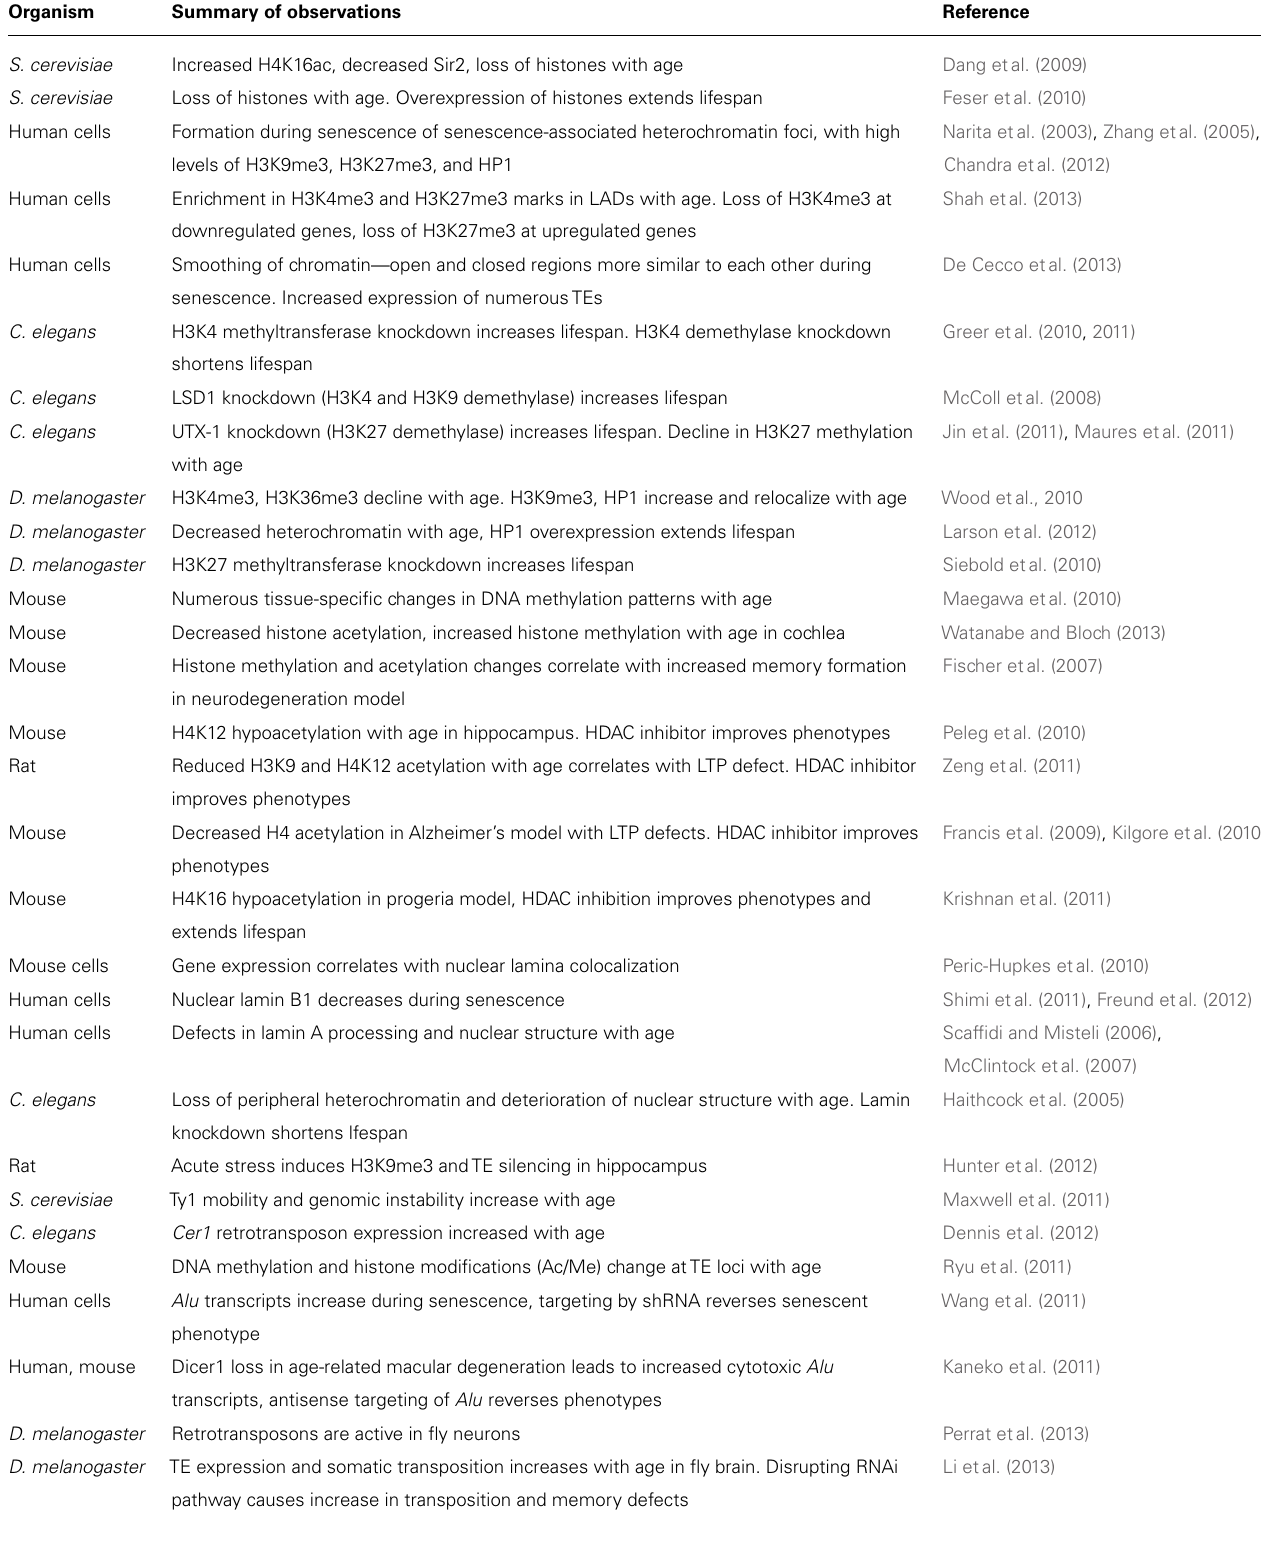
Table 1 | Summary of major findings of recent literature linking aging and